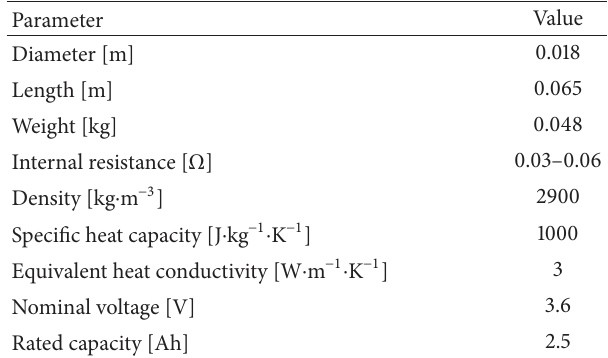
Table 1: Parameters of 18650-type